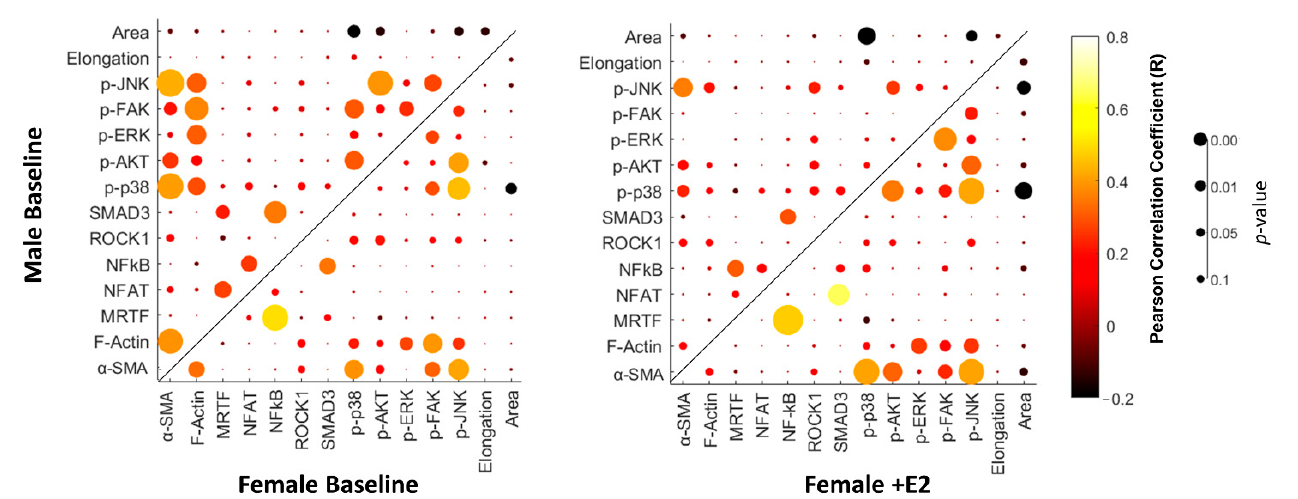
Figure 6. Dot plots of correlation coefficients and their corresponding p -values for analysis of protein–protein and protein– morphology interactions.